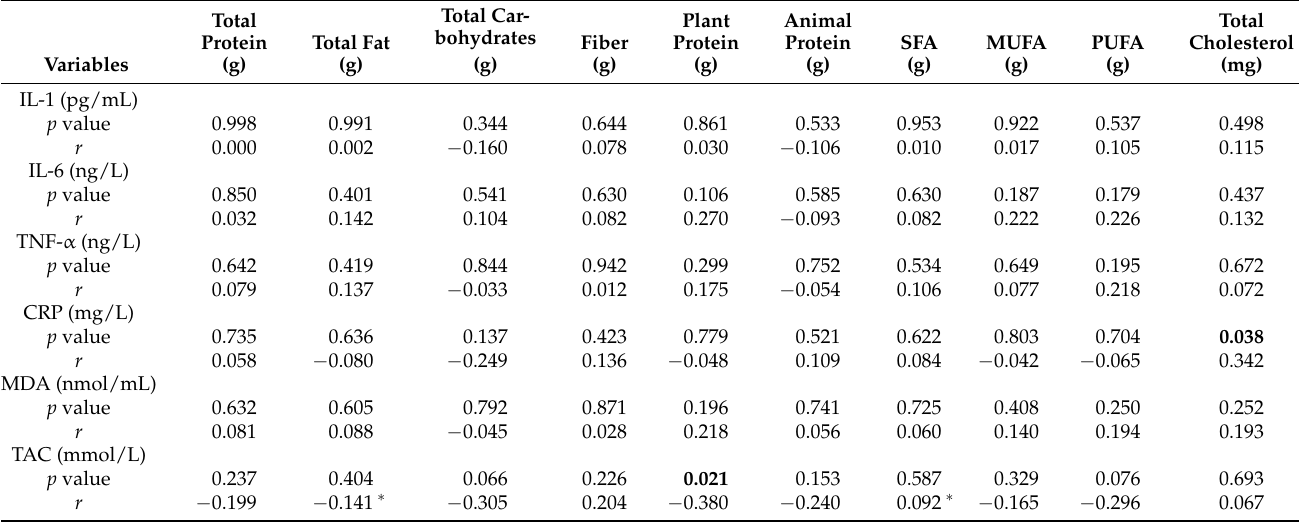
Table 5. Spearman and Pearson’s correlations among Inflammatory and Oxidative Stress markers and macronutrient intakes in Adolescent Girls with PCOS in the N